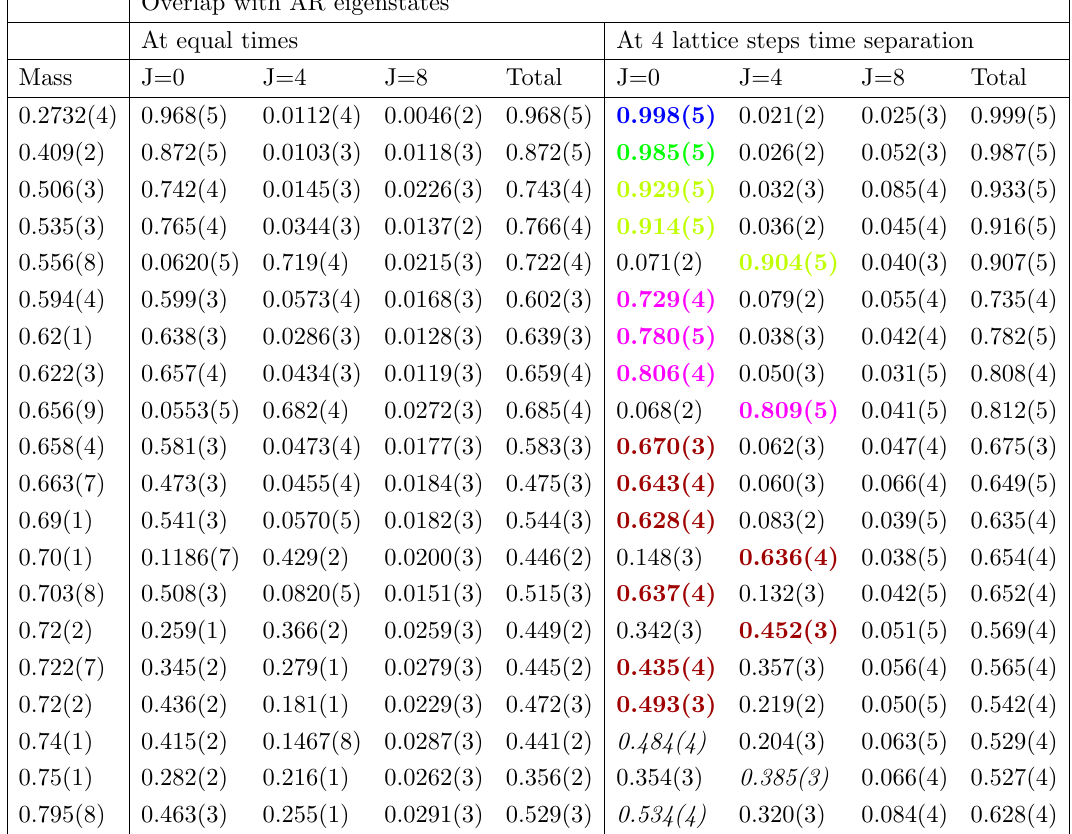
Table 11. Masses from glueballs in A 1 , C = + representations using conventional operators and overlaps with AR